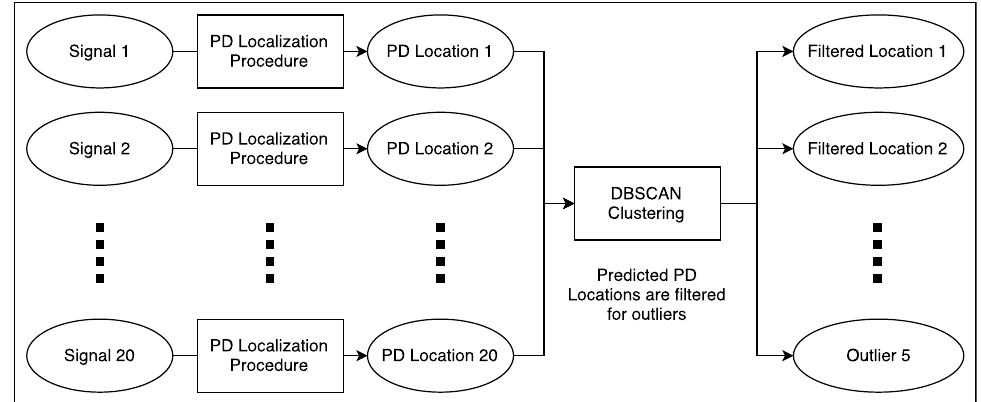
Figure 9. Procedure for finding outliers.